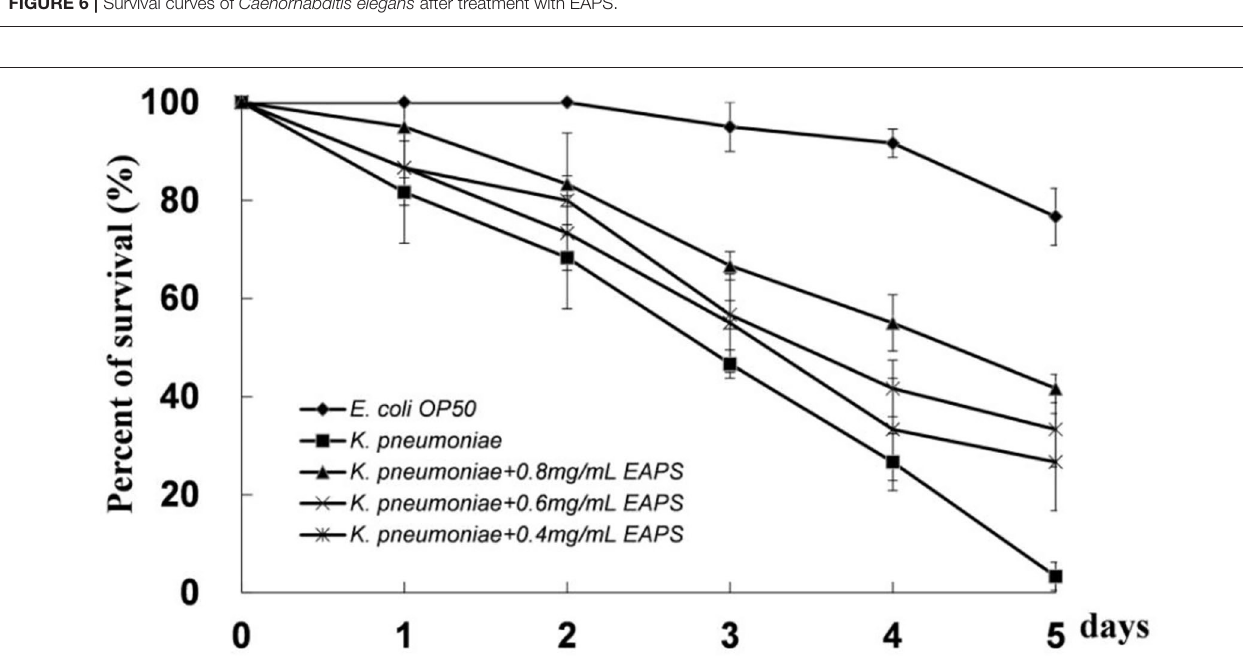
FIGURE 7 | Protective effect of EAPS on C. elegans against Klebsiella pneumoniae infection. The graph represents the average of three independent experiments and an SD.